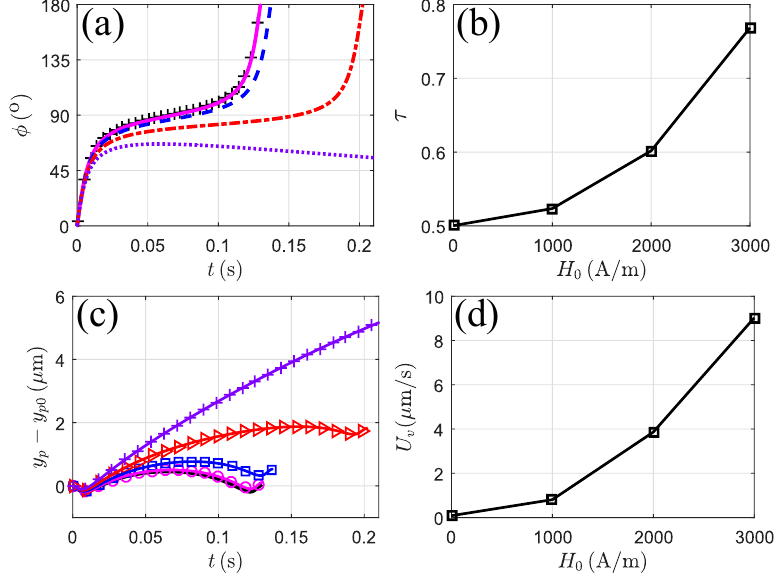
Figure 7. The effect of magnetic field strength on particle transport, with AR = 4, y p 0 = 12 µ m, and α = 0 ◦ . ( a ) φ versus time t over a period: H 0 = 0 (plus symbol), 1000 A/m (solid line), 2000 A/m (dash line), 3000 A/m(dash-dot line) and 4000 A/m (dot line); ( b ) τ varies with the magnetic field strength H 0 ; ( c ) the net migration of particle y p − y p 0 over a period: H 0 = 0 (solid symbol), 1000 A/m (circle symbol), 2000 A/m (square symbol), 3000 A/m (triangle symbol) and 4000 A/m (plus symbol); ( b ) the average vertical migration velocity U v varies with the magnetic field strength H 0